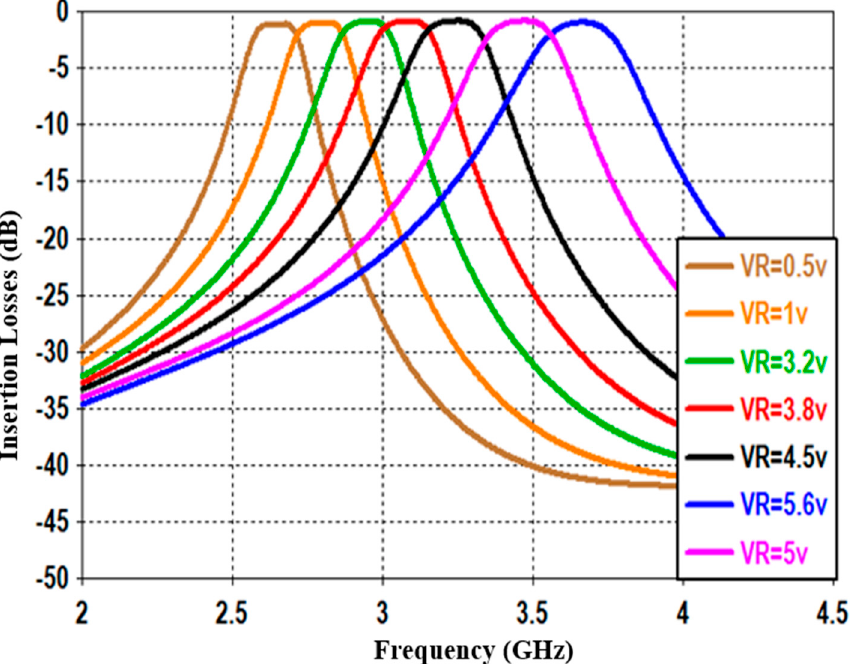
Figure 14. Measured insertion losses with different DC reverse bias voltages for the presented reconfigurable filter.